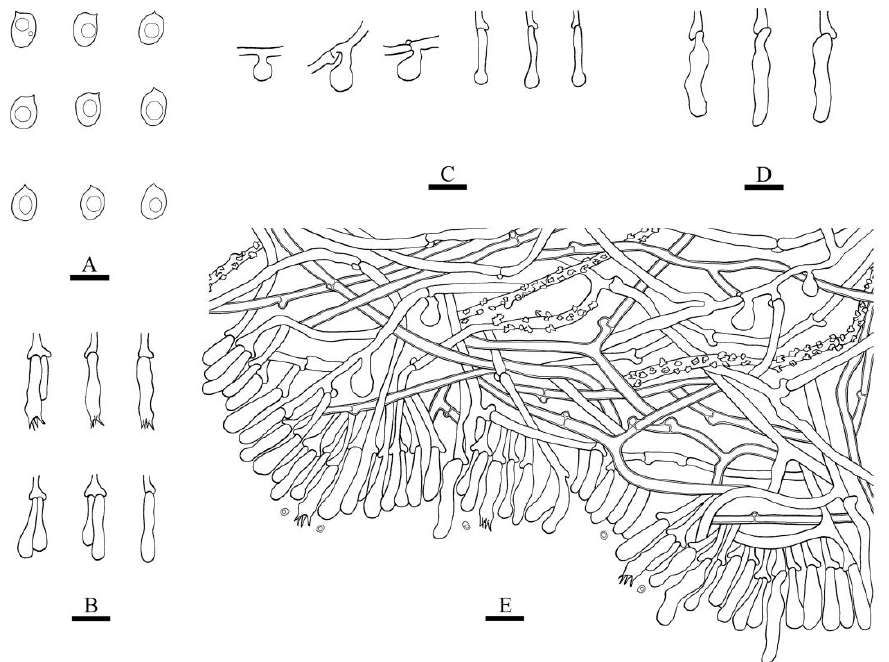
Figure 8. Microscopic structures of Xylodon wenshanensis (holotype): basidiospores ( A ), basidia and basidioles ( B ), capitate cystidia in subiculum and hymenium ( C ), clavate cystidia ( D ), a section of the hymenium ( E ). Bars: ( A ) = 5 µm, ( B – E ) = 10 µm.